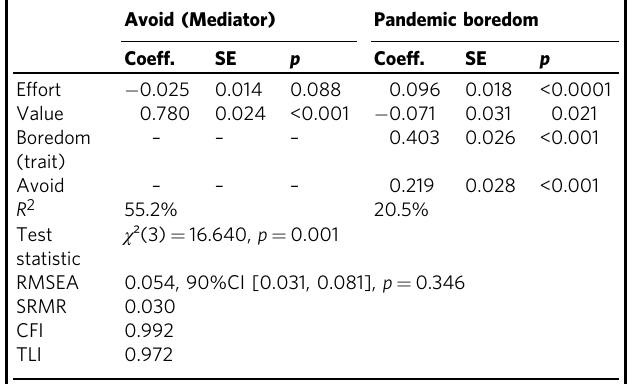
Table 3 Regression coef fi cients, standard errors, and summary information for the thanksgiving model.